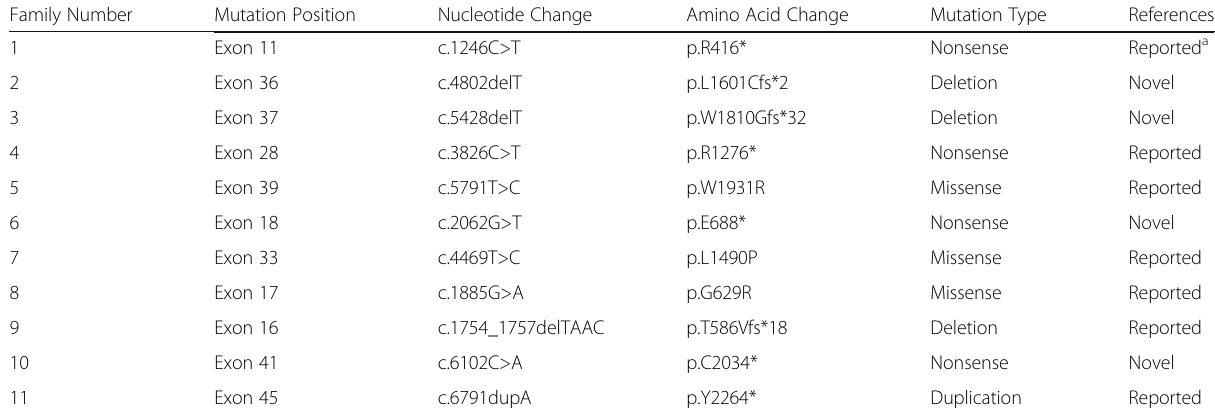
Table 2 NF1 mutations identified in this study